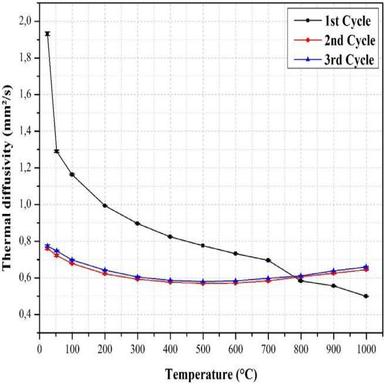
1. Thermal diffusivity measurement of Hornfels rock during three consecutive thermal cycles.